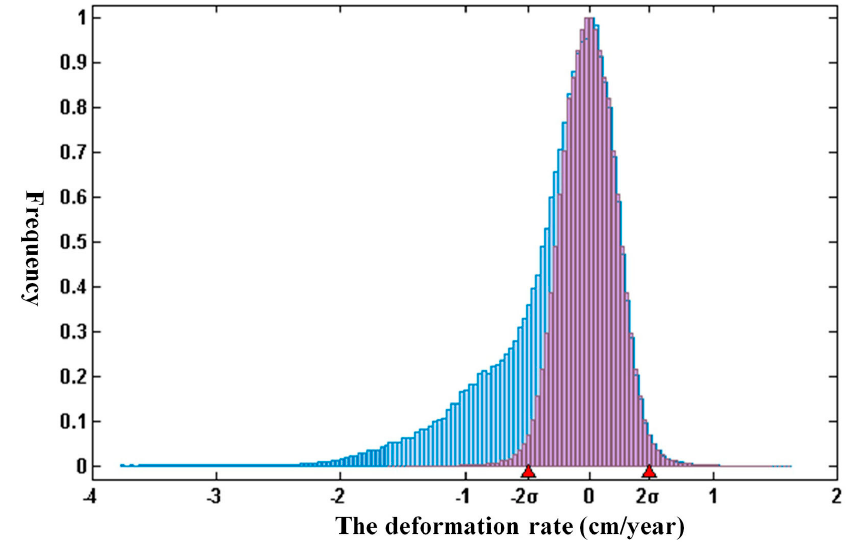
Figure 7. Histogram of vertical deformation rates from Figure 4; red arrows show the 2 σ confidence interval.